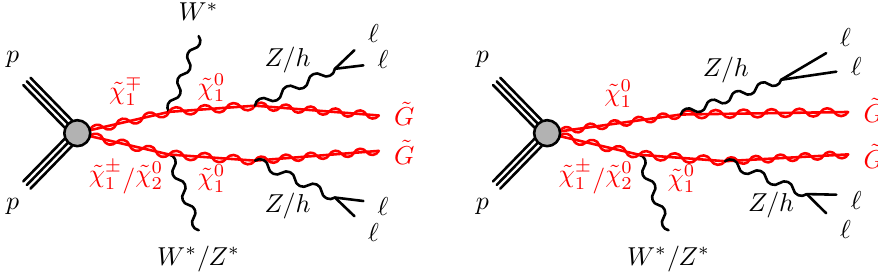
Figure 1. Diagrams of the processes in the SUSY RPC GGM higgsino models. The W ∗ / Z ∗ ˜ χ 0 produced in the ˜ χ ± decays are off-shell ( m ∼ 1 GeV) and their decay products are usually 2 1 / not reconstructed. The Higgs boson may decay into leptons and possible additional products via intermediate ττ , WW or ZZ